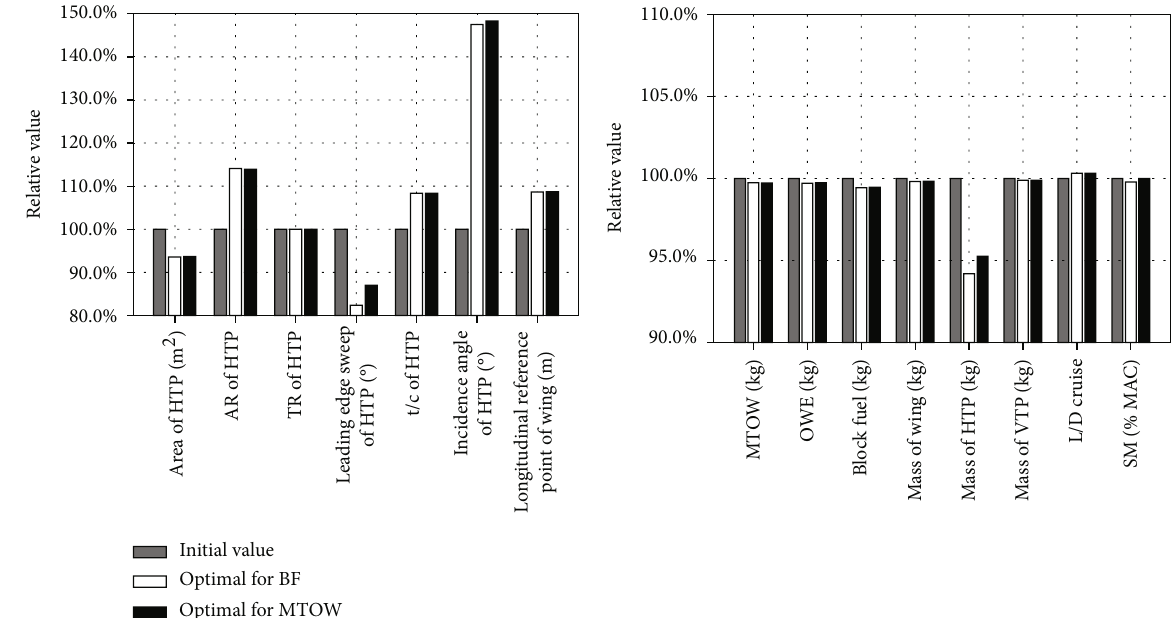
Figure 1: Relative changes of design variables, design constraints, and design objectives for HTP